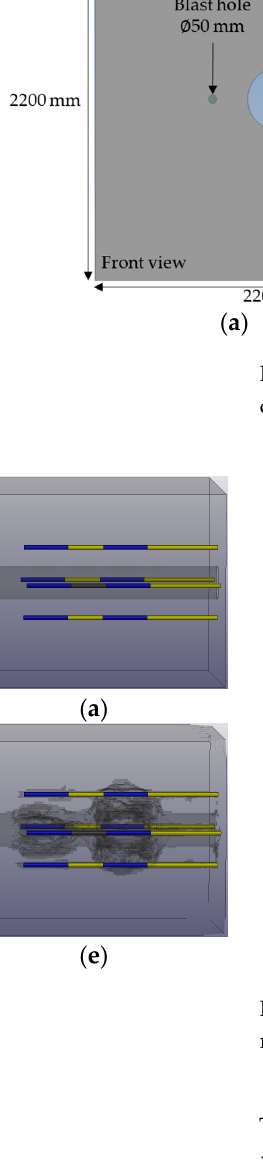
Figure 11. Numerical analysis results of the modified LLB method with deck charge technique: ( a ) 0 ms, ( b ) 0.5 ms, ( c ) 1.0 ms, ( d ) 1.5 ms, ( e ) 20.0 ms, ( f ) 20.5 ms, ( g ) 21.0 ms, ( h ) 21.5 ms.